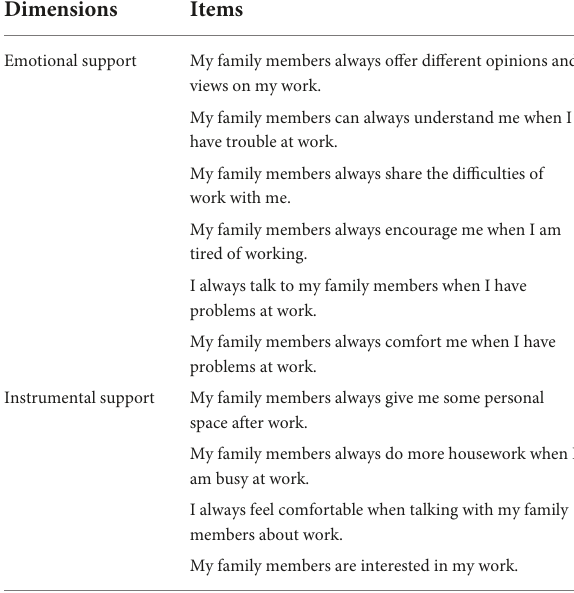
TABLE 3 Measurement items of family support.